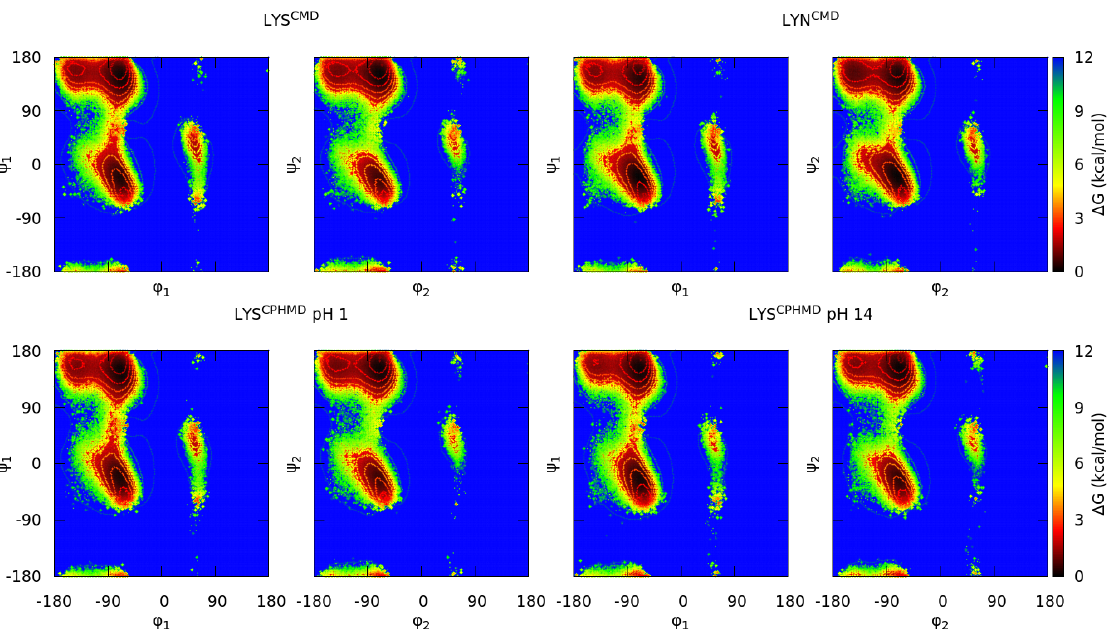
Figure 2. Gibbs free energies in the Ramachandran space of the blocked Lys 2 tripeptide. Each subtitle indicates the residue, the simulation method (in the superscript), and the pH (only for the CPHMD simulations). Both sets of dihedrals ( ϕ 1 / ψ 1 from the N-terminal amino acid; ϕ 2 / ψ 2 from the C-terminal amino acid) are illustrated. Protonated forms are in the left (CMD; top—CPHMD; bottom) and deprotonated ones in the right (CMD; top—CPHMD; bottom). Solid lines indicate an increase of 0.6 kcal/mol of the energy values.